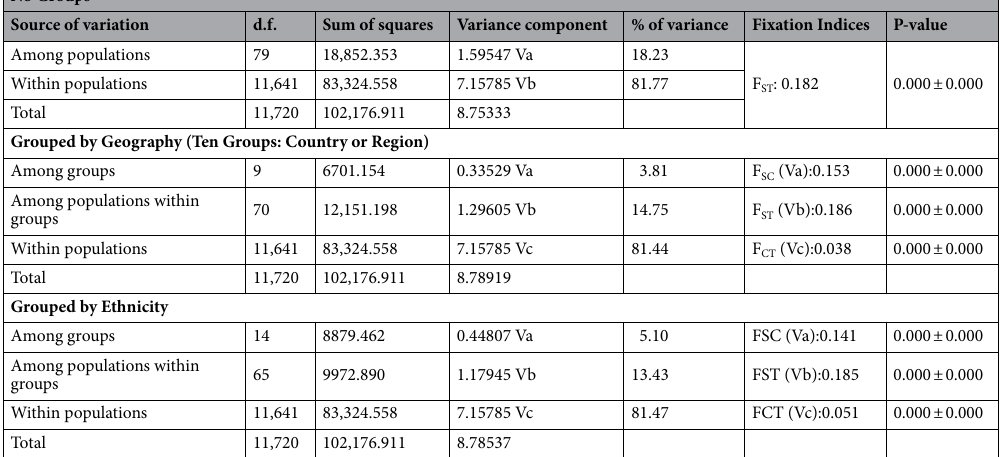
Table 4. AMOVA results for Y-STR haplotypes in KPP and comparative